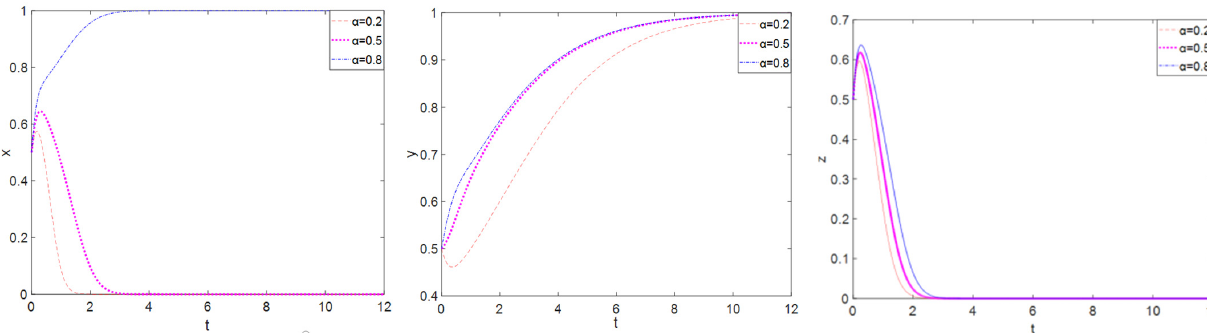
Figure 1. The influence of tax preference on the behavior of suppliers of collaborative innovation in green building projects of construction enterprises according to evolutionary